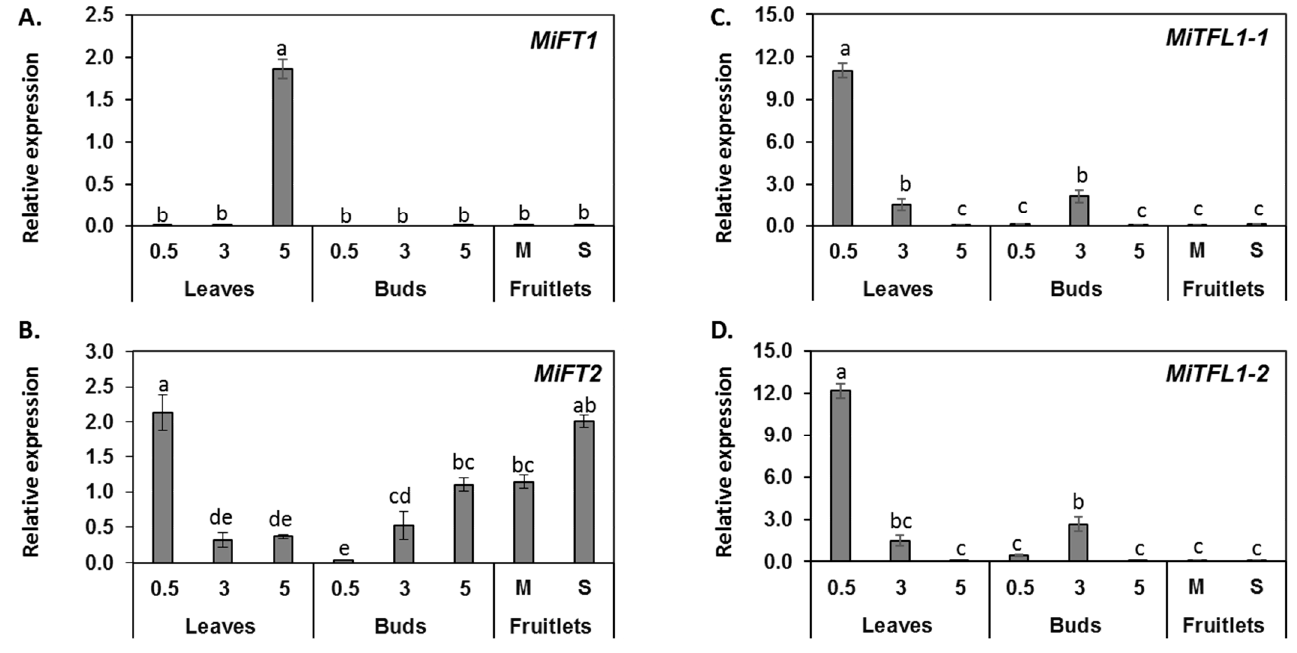
Figure 5. Expression of MiFT/TFL1 genes in various tissues. Expression profiles of MiFT1 ( A ), MiFT2 ( B ), MiTFL1-1 ( C ) and MiTFL1-2 ( D ) genes in leaves and buds of 0.5- or 3-year-old seedlings and 5-year-old grafted ‘Shelly’ trees, and in fruitlet Mesocarp (M) and Seed (S) tissues. The data are mean of three replicates ± SE. Different letters indicate significant differences according to Tukey–Kramer multiple comparison test, with p ≤ 0.05.